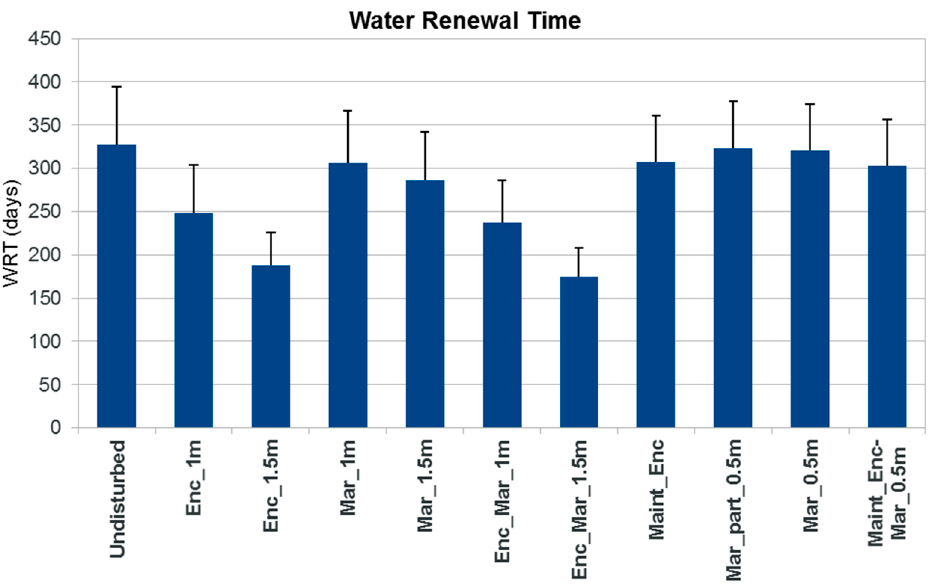
Figure 13. Average water renewal time (WRT) and STDEV of the WRT (black lines) in the Mar Menor lagoon for each simulation.